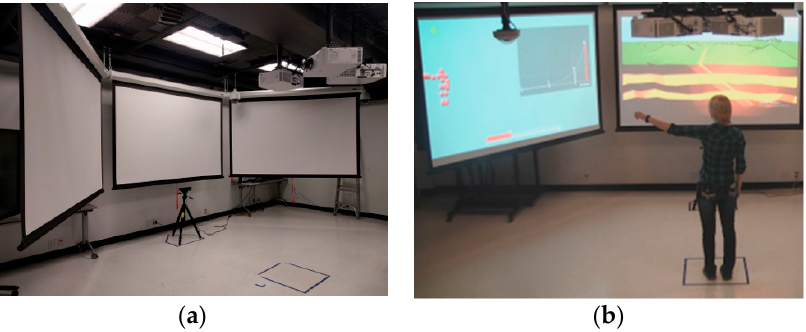
Figure 1. The simulation space configured for motion tracking of a three-screen simulation: ( a ) ceiling mounted audio and video recording; ( b ) a student using the earthquake simulation.